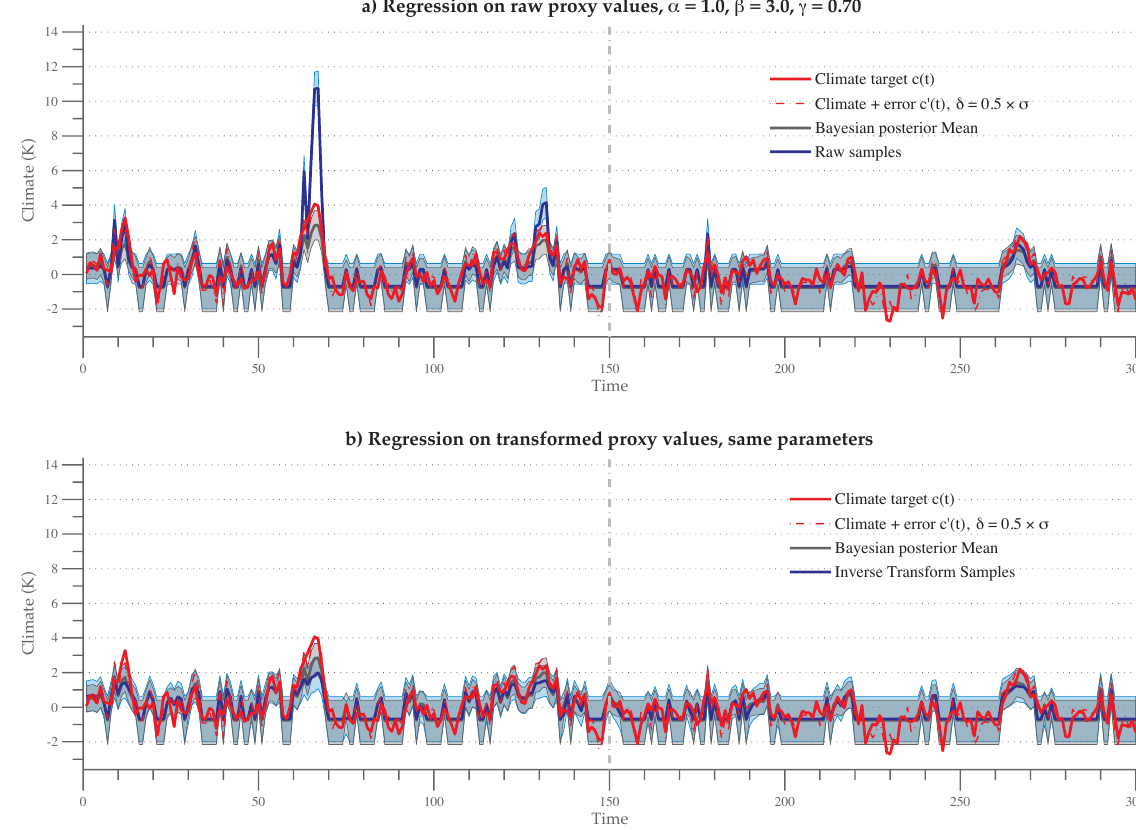
Figure 4. Inferences on simulated c ( t ) using three different methods. (a) Inference using regression on raw proxy values (blue) and the Bayesian model (grey). (b) Inference using regression on transformed proxy values (blue) as well as the Bayesian model (grey). In both panels, c ( t ) and c (cid:48) ( t ) are shown in solid and dashed red, respectively; blue shading represents 95% frequentist prediction intervals; and grey intervals represent pointwise 95% credible intervals from the Bayesian posterior distribution (see, for example, Tingley and Huybers, 2013).